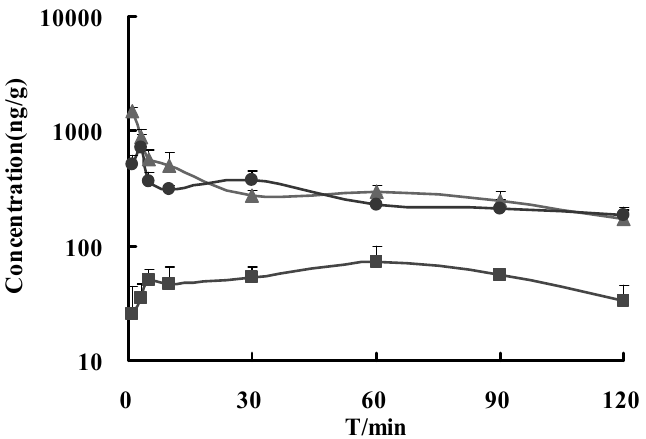
Figure 5. Mean brain concentration-time curve of Ge (18 mg/kg of gardenia extract combined with 18 mg/kg of borneol) via i.n. ( ● ); i.v. ( ▲ ) and i.g. ( ■ ) administration in mice ( n = 5, mean ± S.D.).